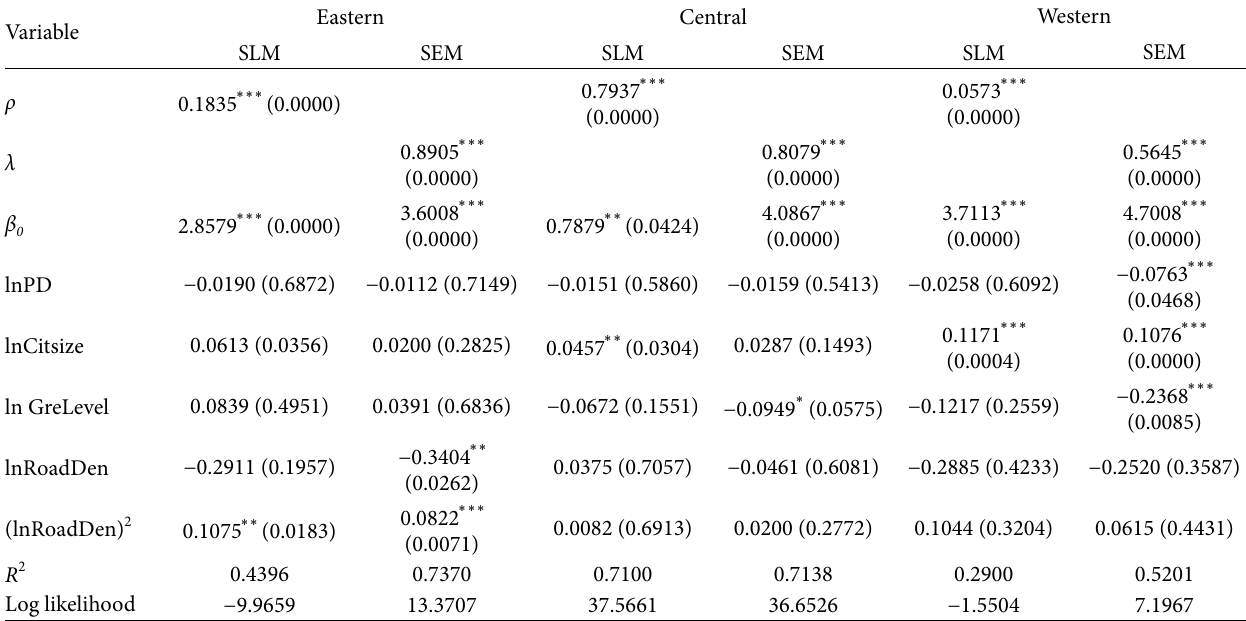
Table 5: Results of spatial regressions in different